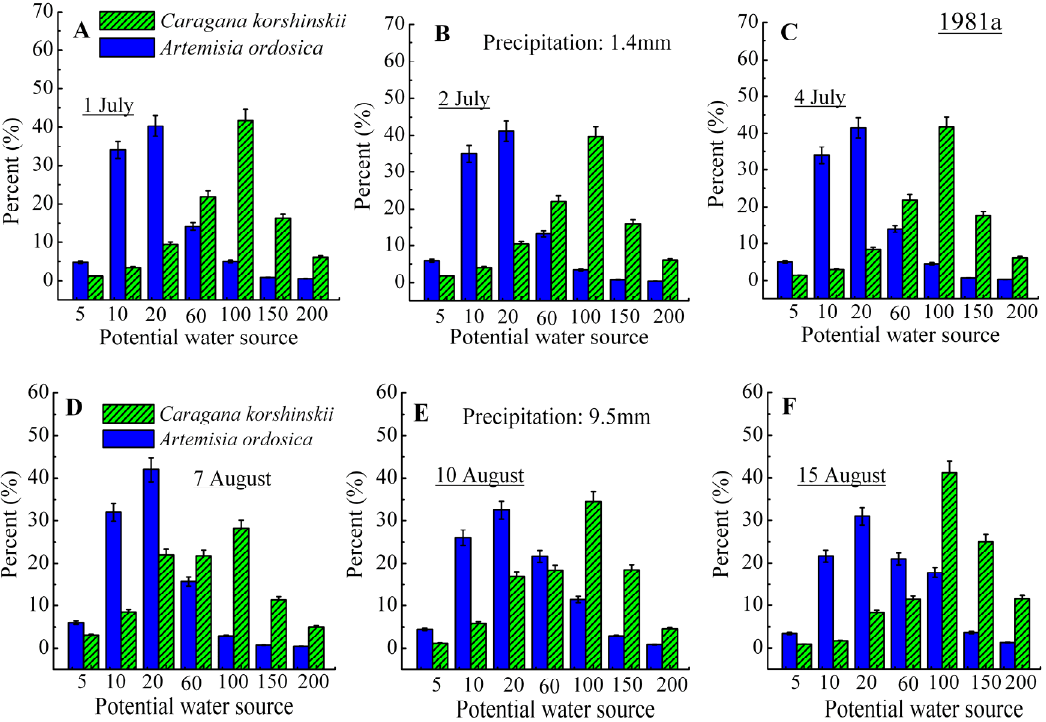
Figure A2. Proportion of potential water source for C. korshinskii and A. ordosica in 1981a revegetated site during a small precipitation event (1.4 mm; A – C ) and a large precipitation event (9.5 mm; D – F ).